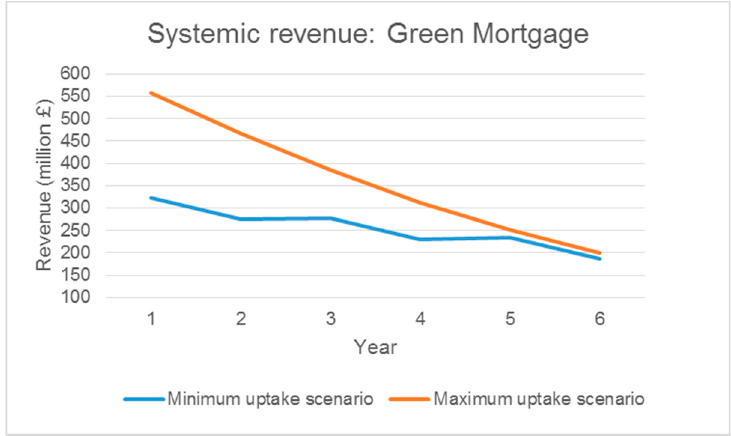
Figure 3. Trajectory of systemic revenue generated by the Green Mortgage (GM) as profits generated in year 10 of loan repayment for upgrades undertaken in year 1–6. Note that the irregular shape of the minimum uptake curve is due to the rate at which households are assumed to undertake upgrades.